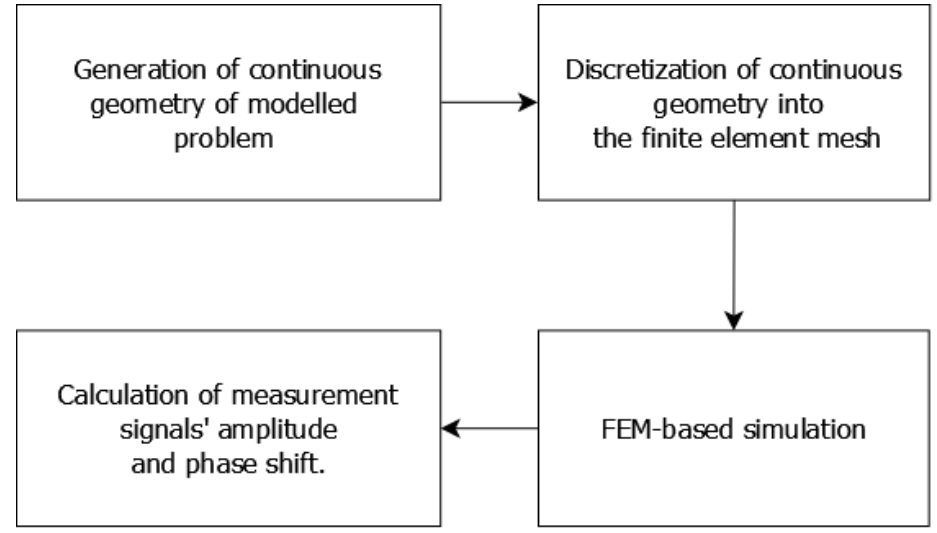
Figure 6. General scheme of FEM modeling for forward tomography transformation in eddy current tomography.